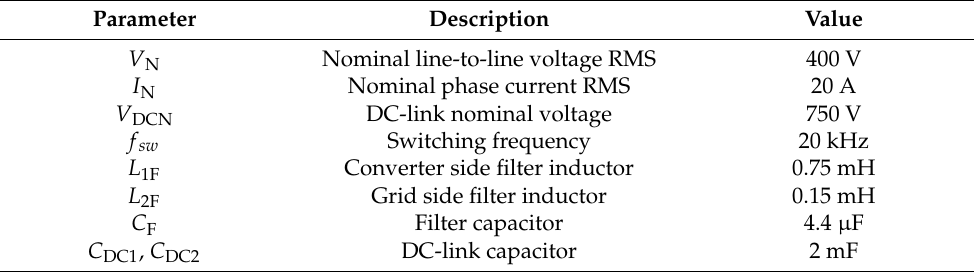
Table 1. Parameters of an investigated active power filter.